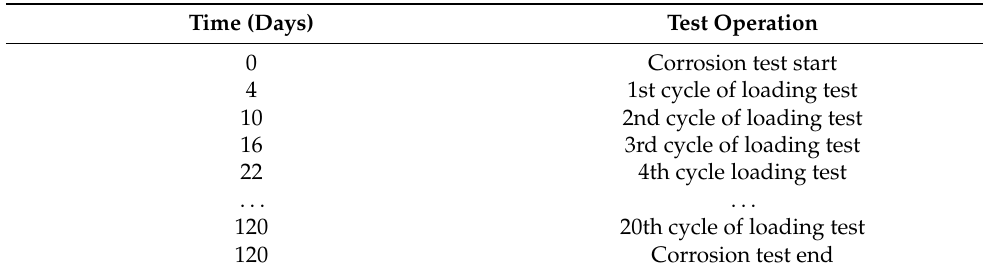
Figure 10. Experimental setup for combined loading–corrosion tests. Table 3. Schedule of interactive loading and corrosion tests.